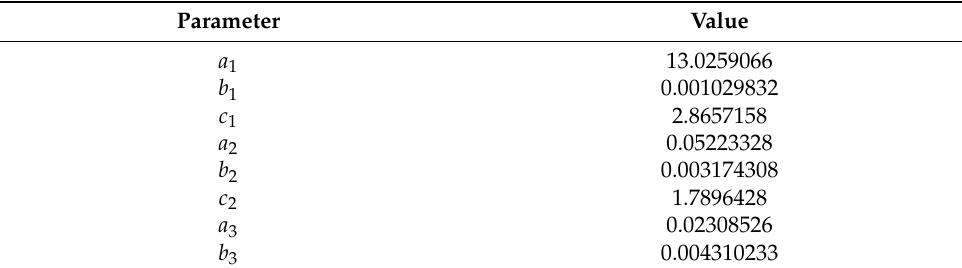
Table 1. Fitting parameters in the first orbit of the spring equinox.